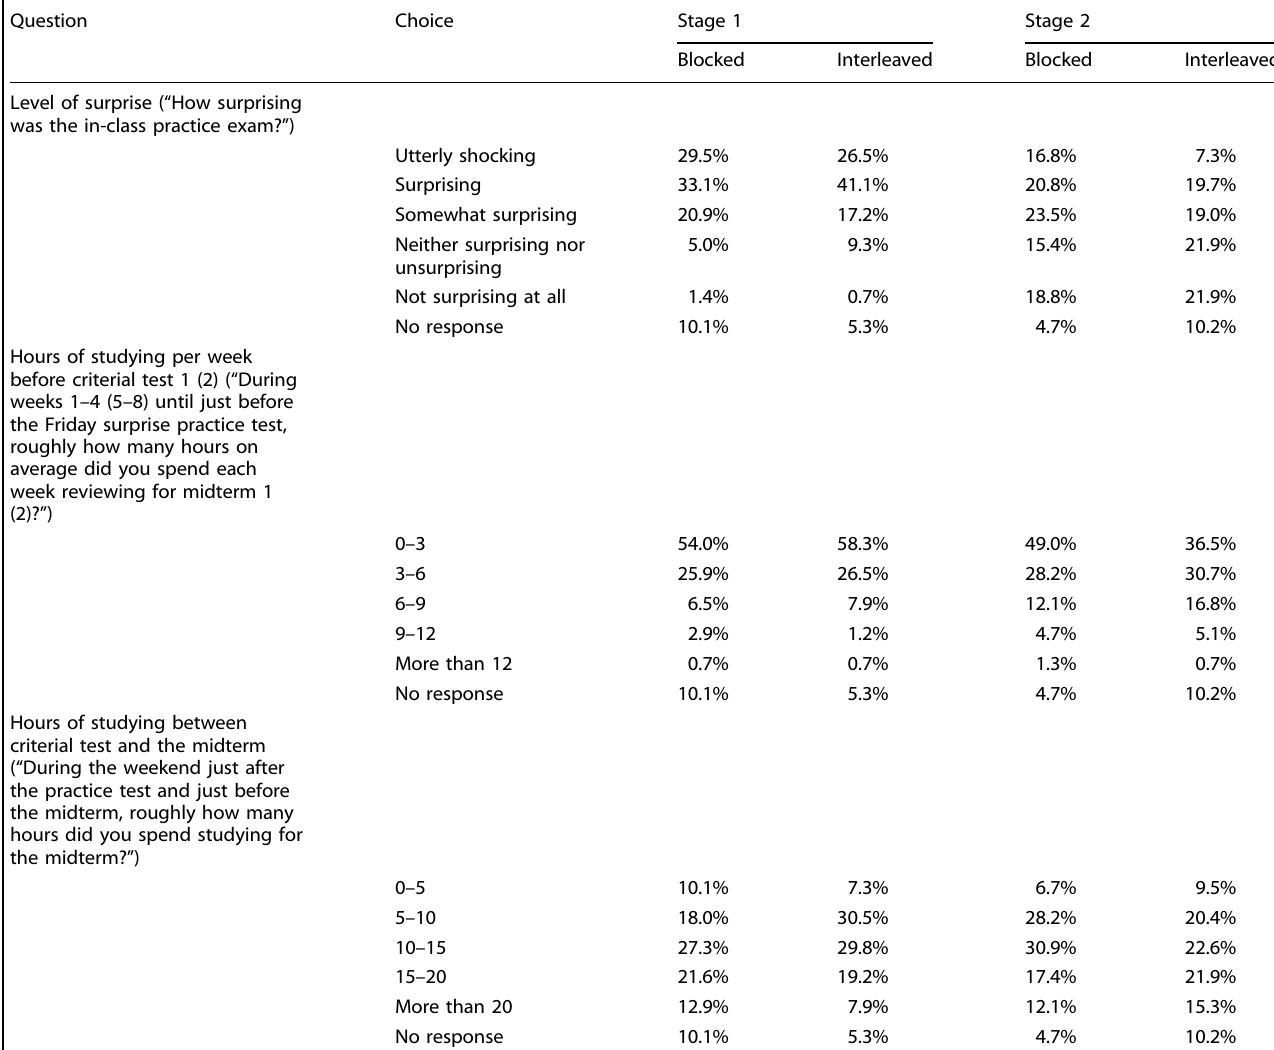
Table 4. Exit survey data. Question Choice Stage 1